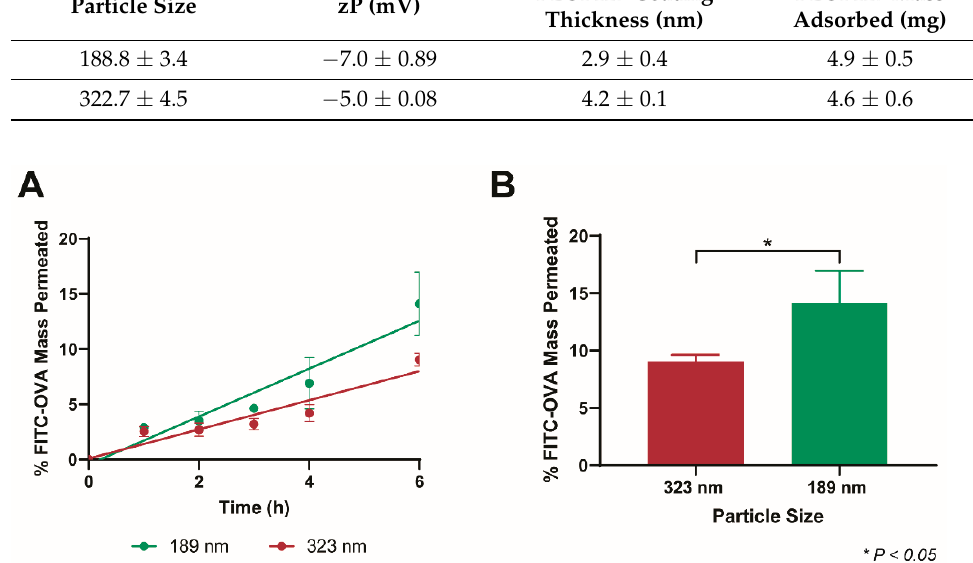
Table 2. PLUF127-coating comparison between 189 nm and 323 nm particle systems. Particle Size